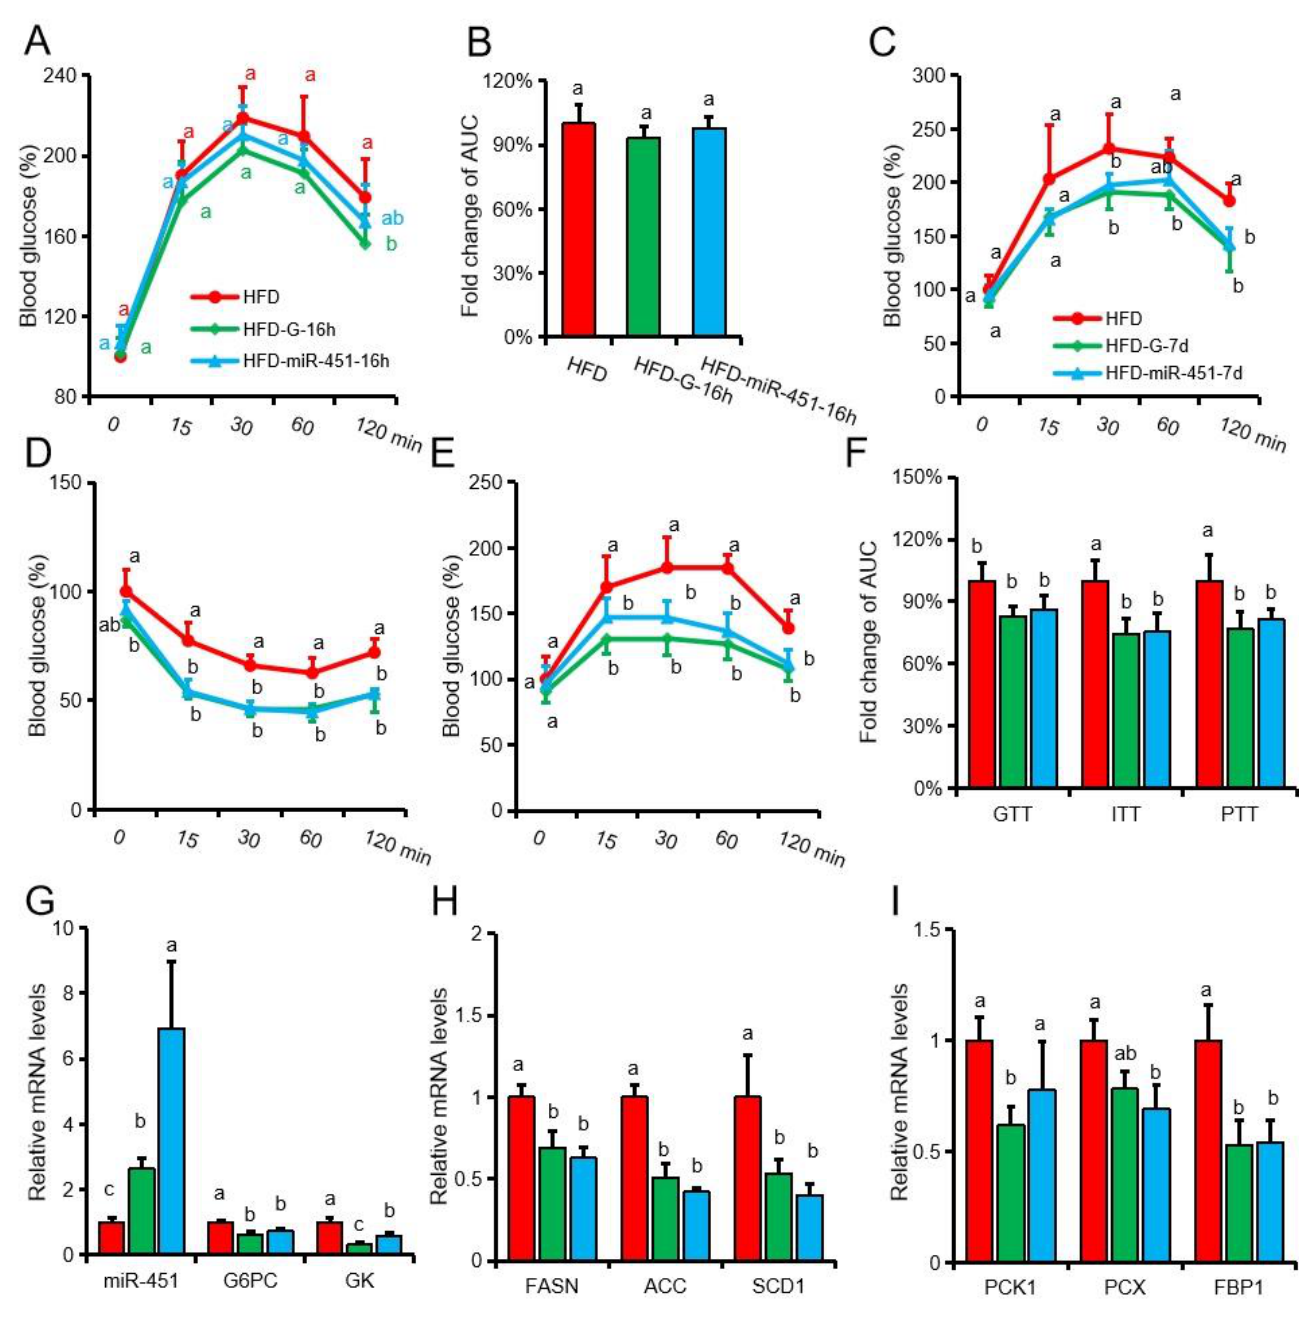
Figure 4. Both genistein and miR-451 agomir can effectively alleviate hepatic gluconeogenesis in obese mice. ( A , B ) Intraperitoneal PTT detection ( A ) and area under the curve ( B ) in obese mice, after genistein feeding for 1 day or injection of miR-451 agomir for 1 time. HFD-G-16h: Genistein supplemented in HFD diet and fed for 16 h, HFD-miR-451-16h: 16h after miR-451agomir injection in HFD diet group. ( C – F ). Intraperitoneal GTT ( C ), ITT ( D ), PTT ( E ) detection and area under the curve ( F ) in obese mice, after genistein feeding for 7 days or injection of miR-451 agomir 7 days. HFD-G-7d: Genistein supplemented in HFD diet and fed for 7 days, HFD-miR-451-7d: 7 days after miR-451agomir injection in HFD diet group. ( G ) Expression of miR-451 and its target genes Gk and G6pc . ( H ) Expression of fat synthesis-related genes in liver. ( B ) Expression of gluconeogenesis-related genes in liver. ( A – F ), n = 6; ( G – I ), n = 3. Different superscript letters indicate significant differences ( p ≤ 0.05), and the same superscript letters indicate insignificant differences ( p >